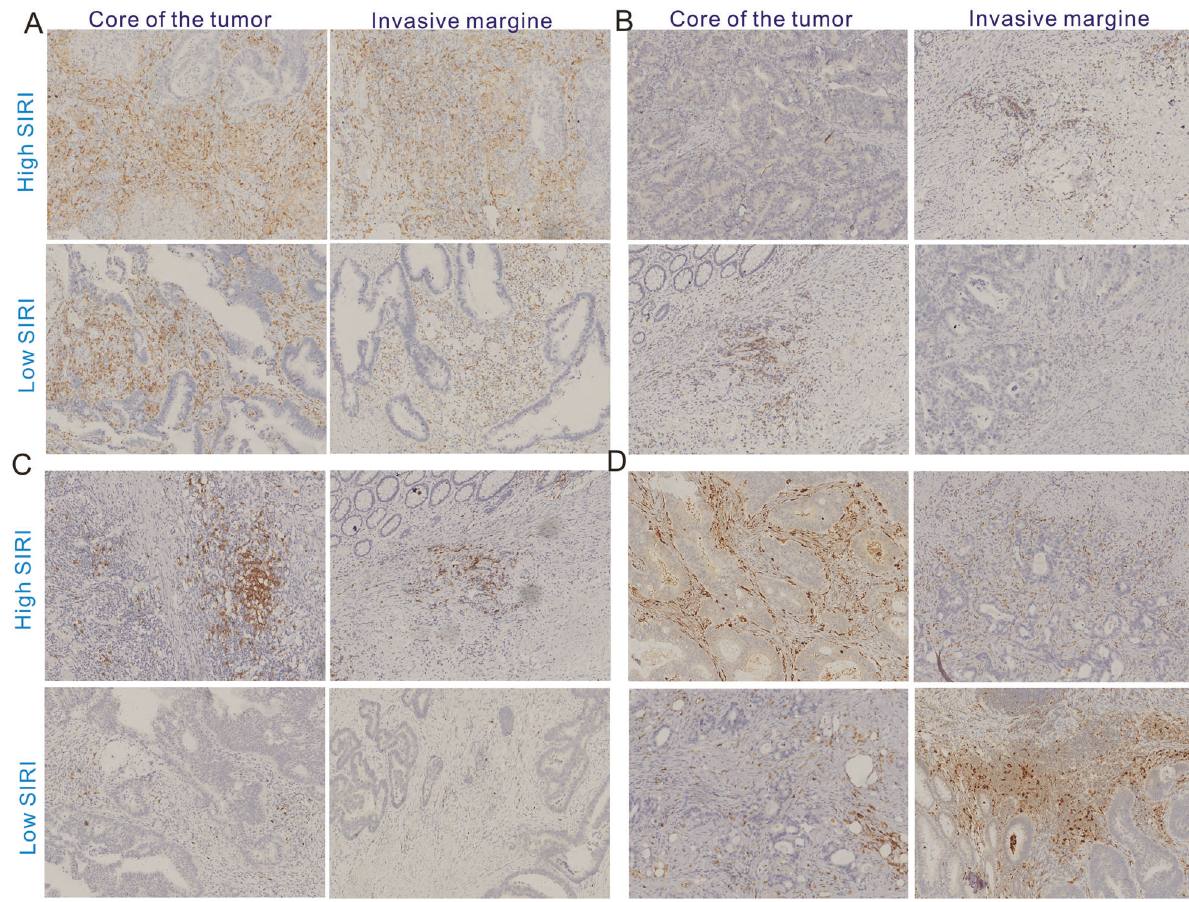
Fig. 5 The representative staining images of immune cells in the low and high SIRI groups. A CD4 + T cells; B CD8 + T cells; C CD20 + B cells; D CD68 +